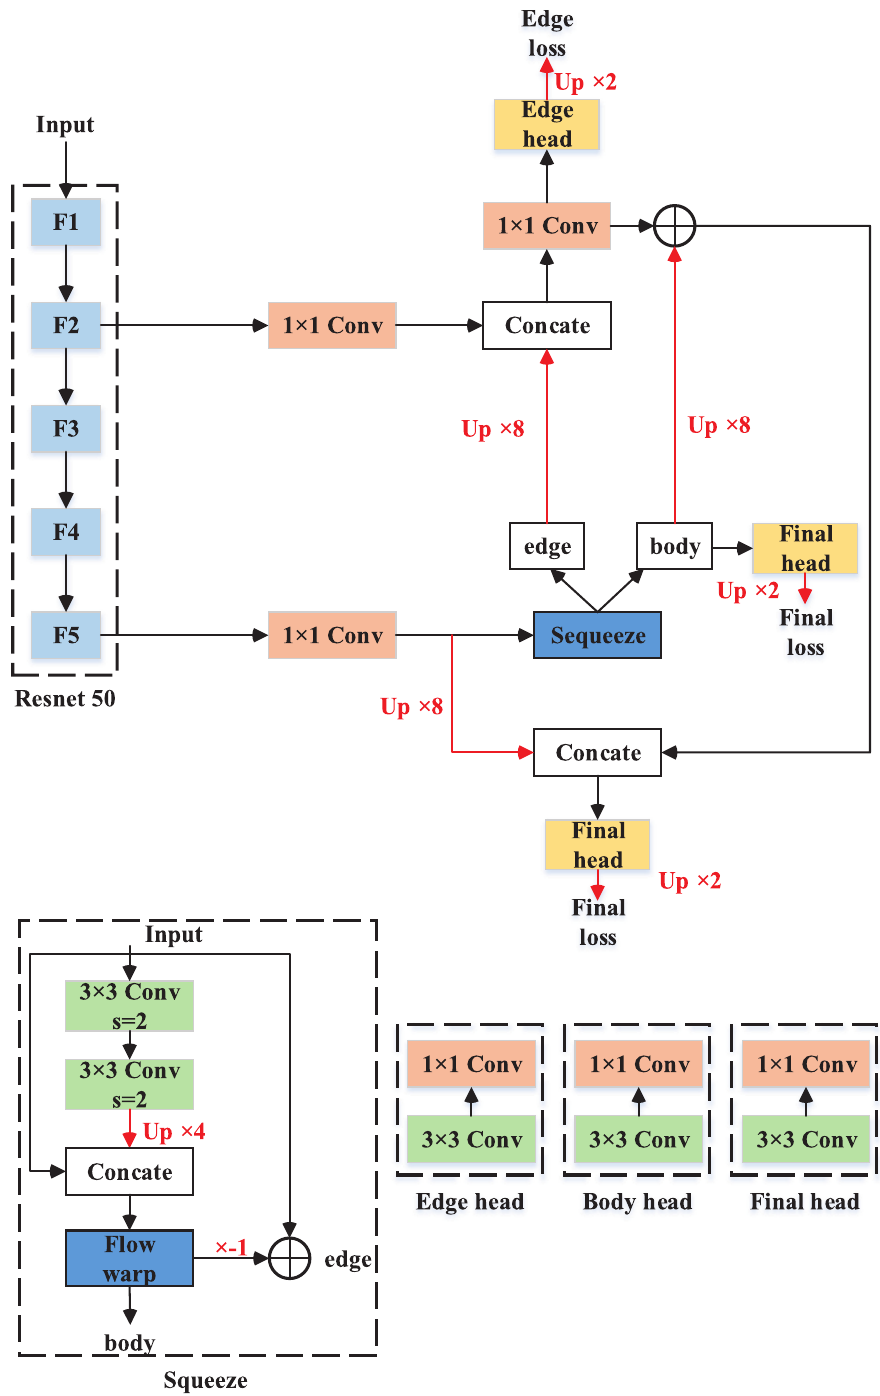
Figure 9. FCN with semantic flows. The red lines represent